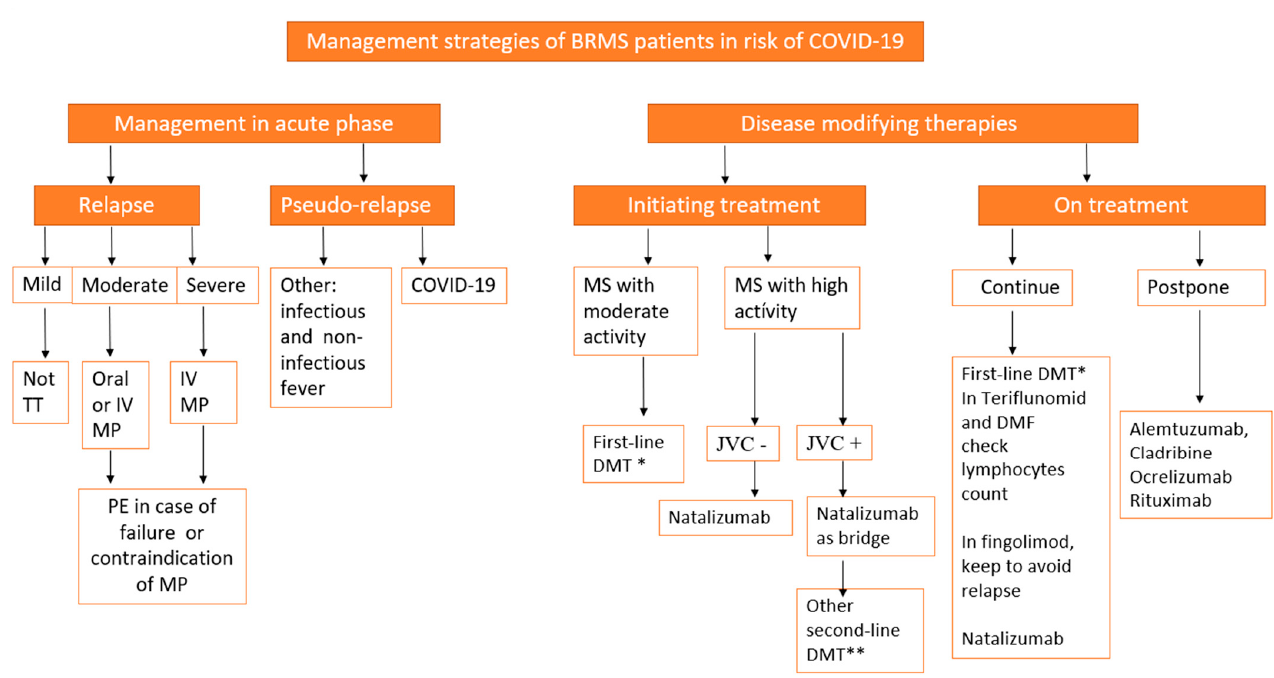
Figure 1. Proposed flowchart to follow in the management of patients with MS outbreak–remission (BRMS) and the risk of COVID-19. Legend: BRMS: benefit versus risk for MS, DMT: disease-modifying therapies, first-line DMT*: interferons, glatirameracetate, dimethyl fumarate (DMF), and teriflunomide, second-line DMT**: natalizumab, fingolimod, AlemtmAb: alemtuzumab, cladribine, Ocre-mAb: ocrelizumab, rituximab, MP: methylprednisolone, PE: plasma exchange, JCV: John Cunningham virus.